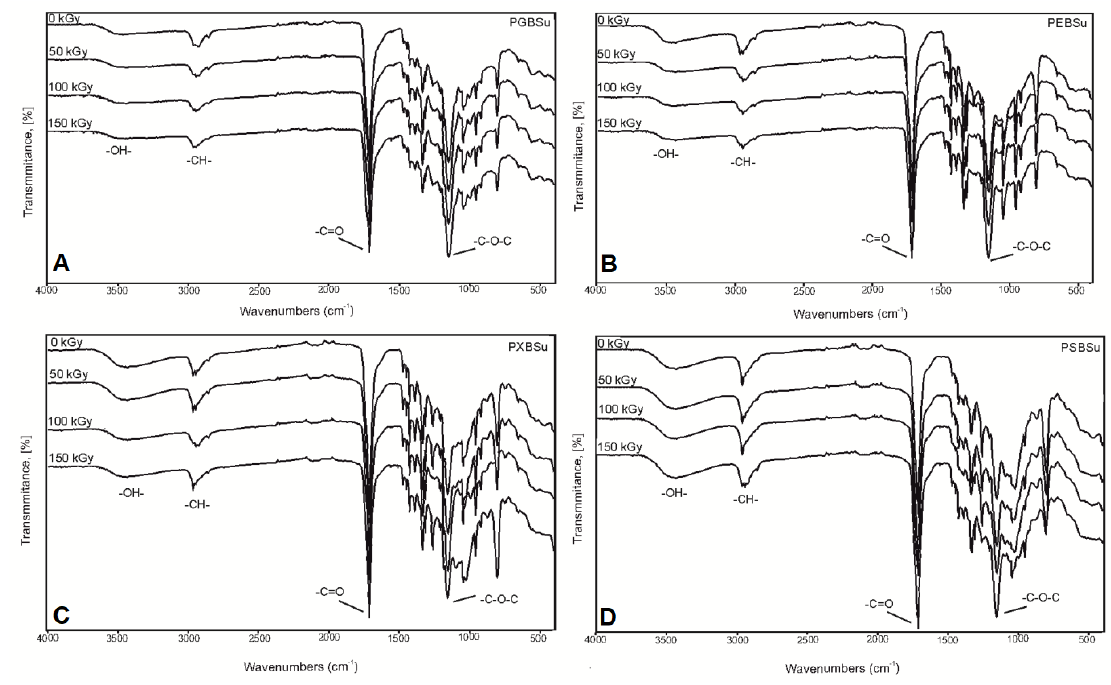
Figure 4. FTIR spectra of PGBSu ( A ), PEBSu ( B ), PXBSu ( C ), and PSBSu ( D ) polymers before and after radiation